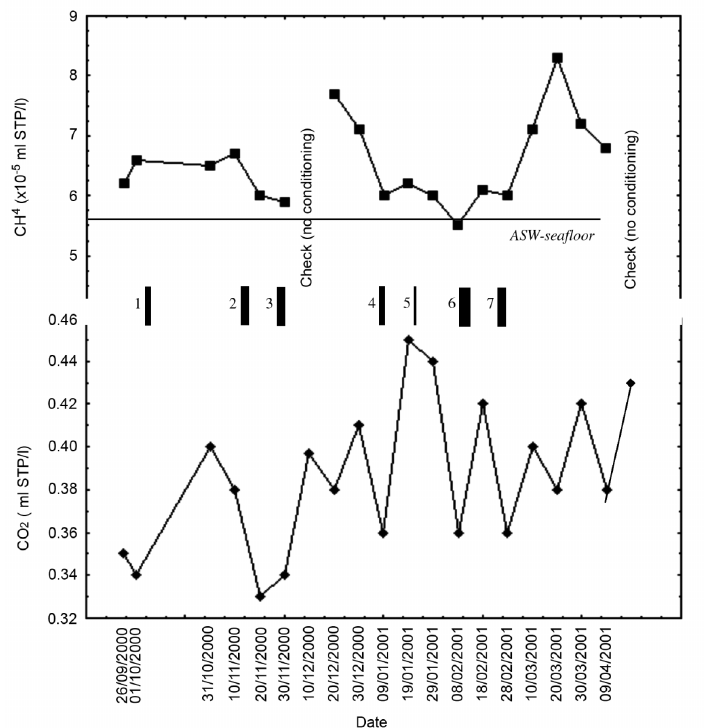
Fig. 3. CO 2 and CH 4 variation. Vertical bars are the seven main T / S events marked in fig. 2a-e. ASW is the Air Saturated Water (equilibrium with the atmosphere calculated at seafloor conditions). Checks are the samples where no preservative was used and therefore all CH 4 was consumed by